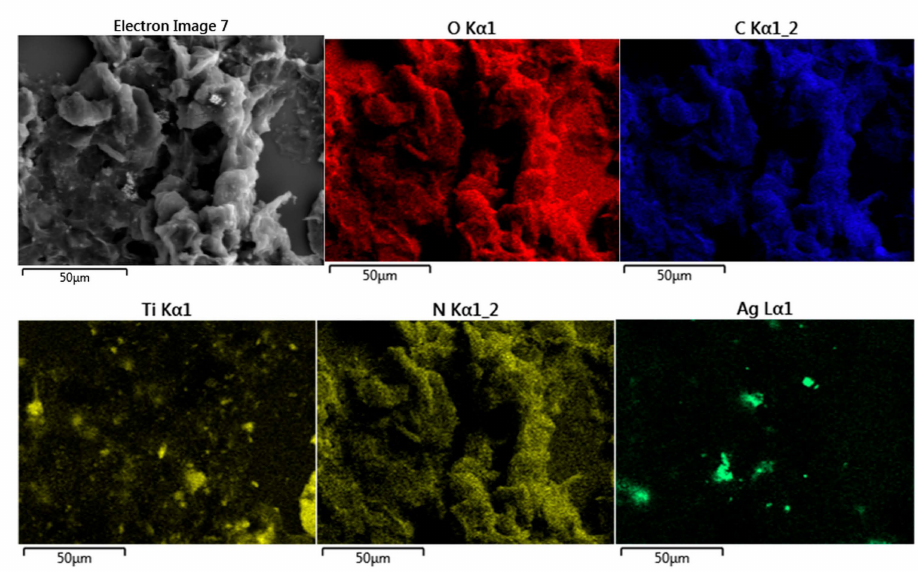
Figure 5. EDS elemental mapping of the as-synthesized porous 3D black TiO 2 /Ag/N@rGO